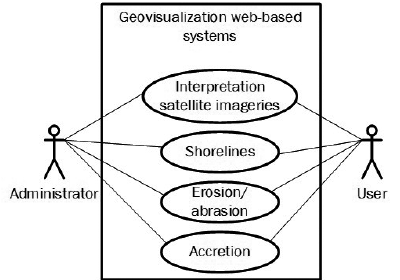
Figure 6. Use case diagram of geovisualization system shoreline changes